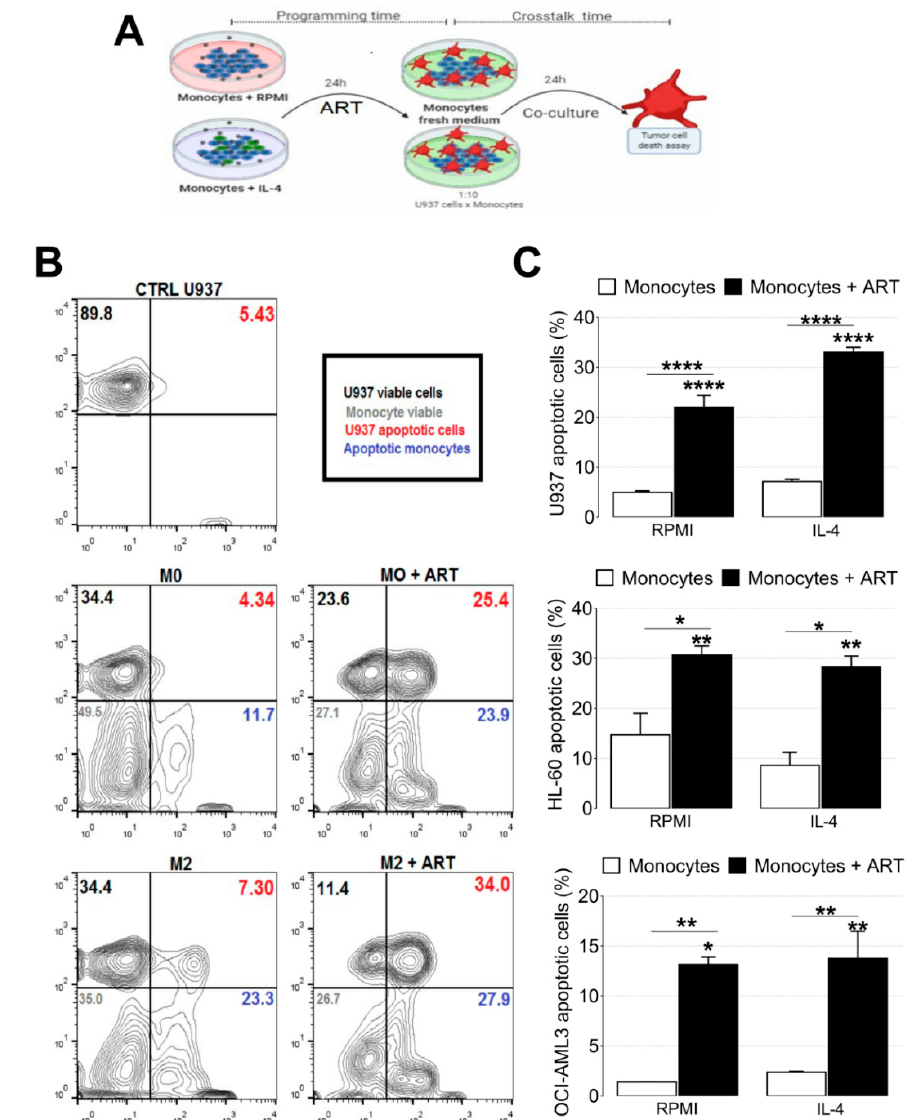
Figure 6. ART treatment reduces in vitro leukemia growth by modulating monocytes with the ability to kill leukemic cells. Experimental design of the co-culture protocol ( A ). Monocytes were treated with 500 μ M of ART for 24 h in the presence or not of IL-4. Representative dot plot ( B ). U937, HL60, and OCI-AML3 were added in a fresh medium for more 24 h and the cells were stained with Annexin V ( C ). Data represent mean ± SEM of at least three independent experiments per- formed in triplicate. Data were analyzed by ANOVA followed by Tukey post hoc. *, **, and ****, significantly different from control RPMI cells or IL-4